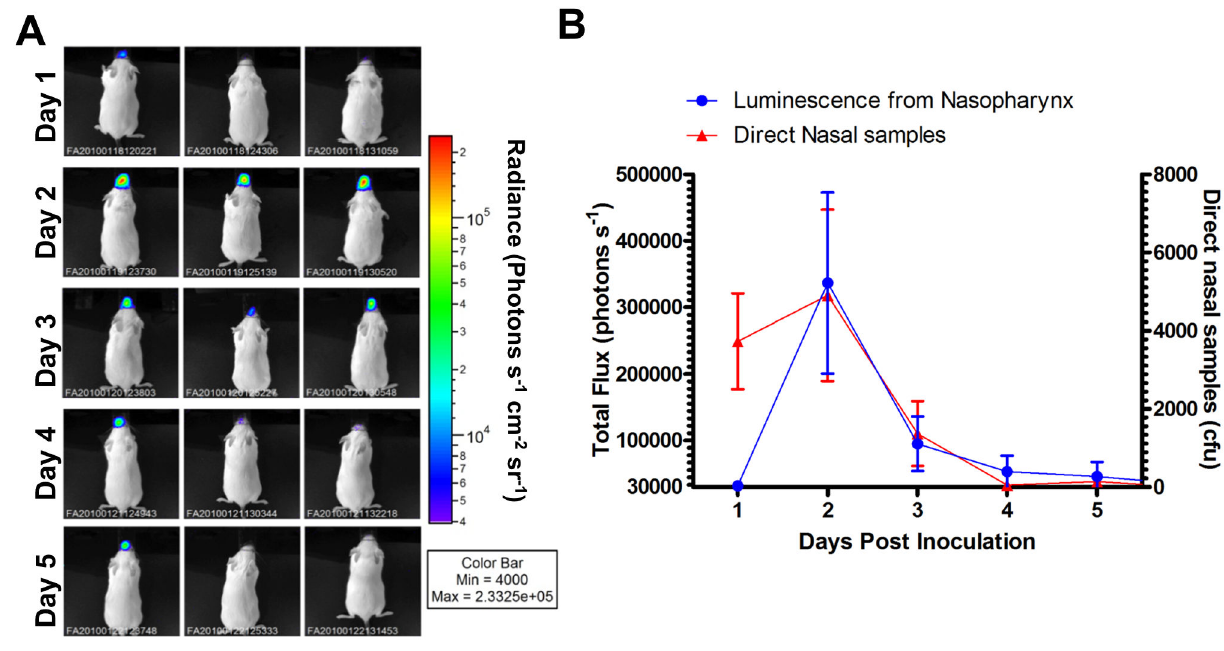
Figure 5. Imaging of S. pyogenes with a stably integrated lux operon over a time course. Mice (n=6) intranasally inoculated with S. pyogenes (H347::lux) were imaged over five days (A, three representative mice shown for each time point) to demonstrate anatomical localisation. Total flux from the nasopharynx was measured daily alongside longitudinal measurement of S. pyogenes nasal shedding (B, n=6). doi: obtained from mice ex vivo (Figure 6 C, n=18, r 2 >0.95). The signal obtained from the nasal associated lymphoid tissue (NALT) did not correlate to the detected luminescence (Figure 6 D, n=18) possibly because the burden was too low to be detected.